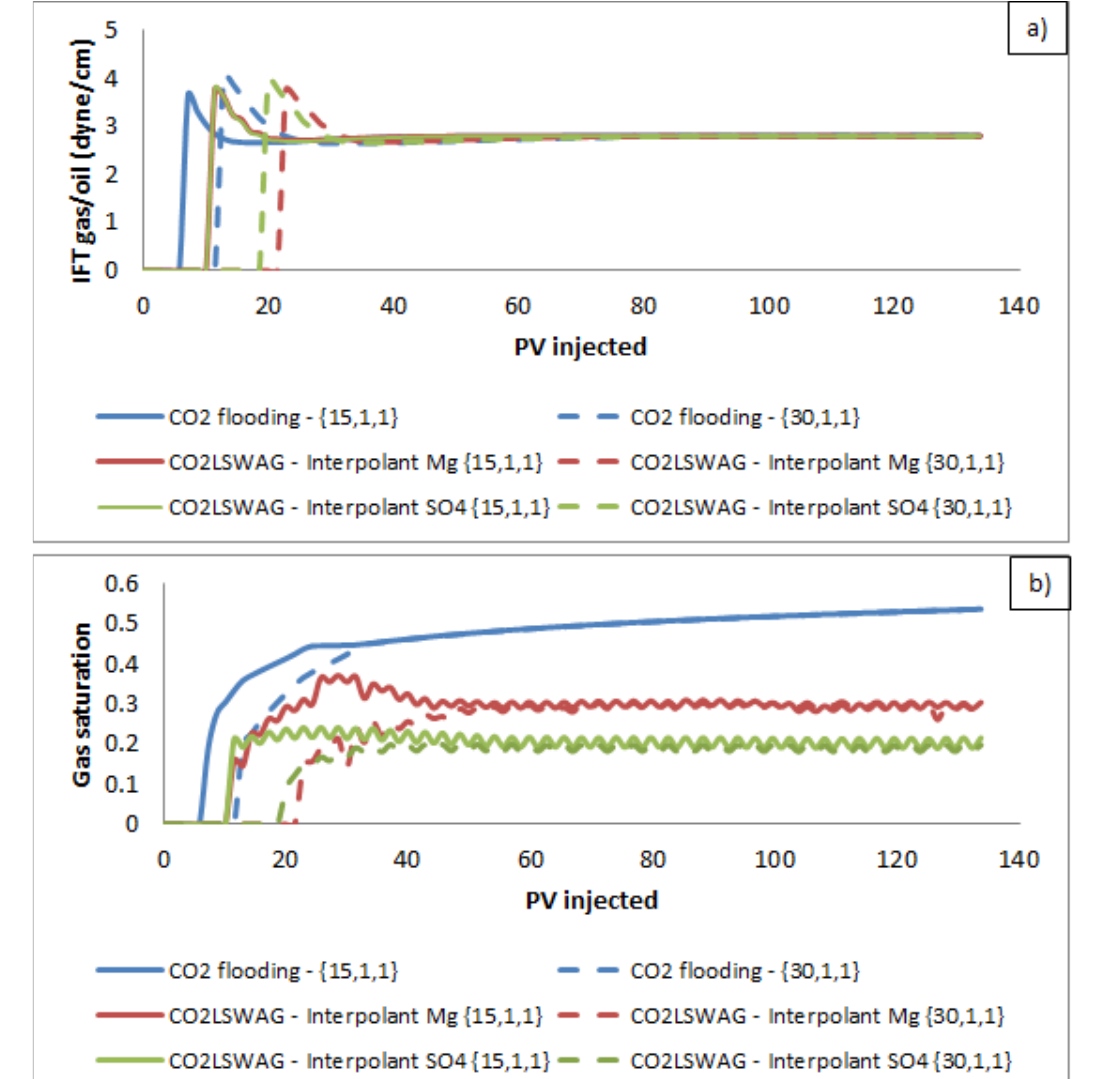
Figure 15. ( a ) Interfacial tension gas/oil and ( b ) gas saturation at grid blocks {15,1,1} and {30,1,1} for continuous CO 2 injection and CO 2 -LSWAG considering Mg and SO 4 as ion interpolants.